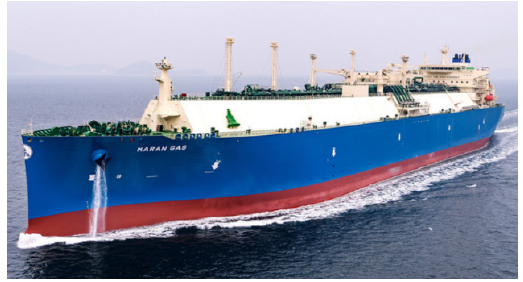
Figure 13. Target vessel—173 K LNG Carrier. Table 2. Principal dimension of 173 K LNG Carrier.